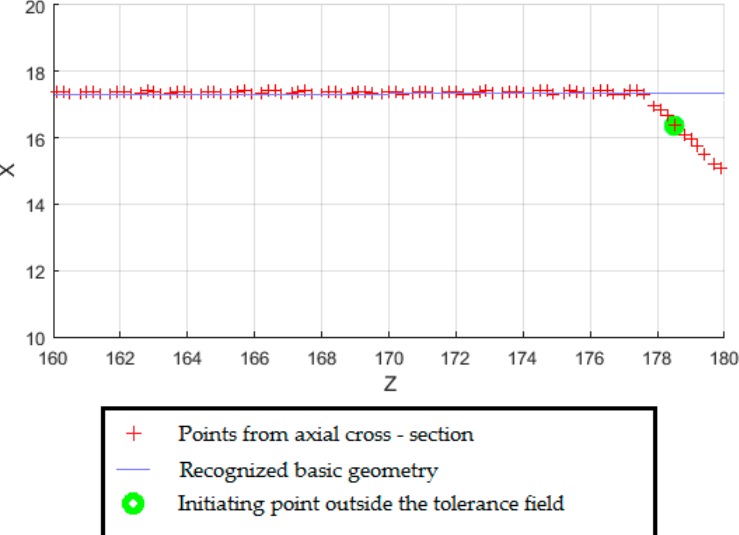
Figure 9. Chamfer detection based on axial cross-section. Table 1. Matrix of recognized geometric properties.